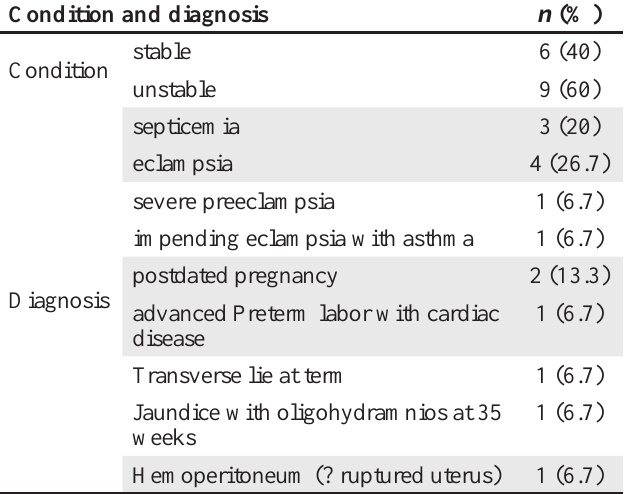
Table 2 : Condition of the mothers and provisional diagnosis at the time of admission (N =15)